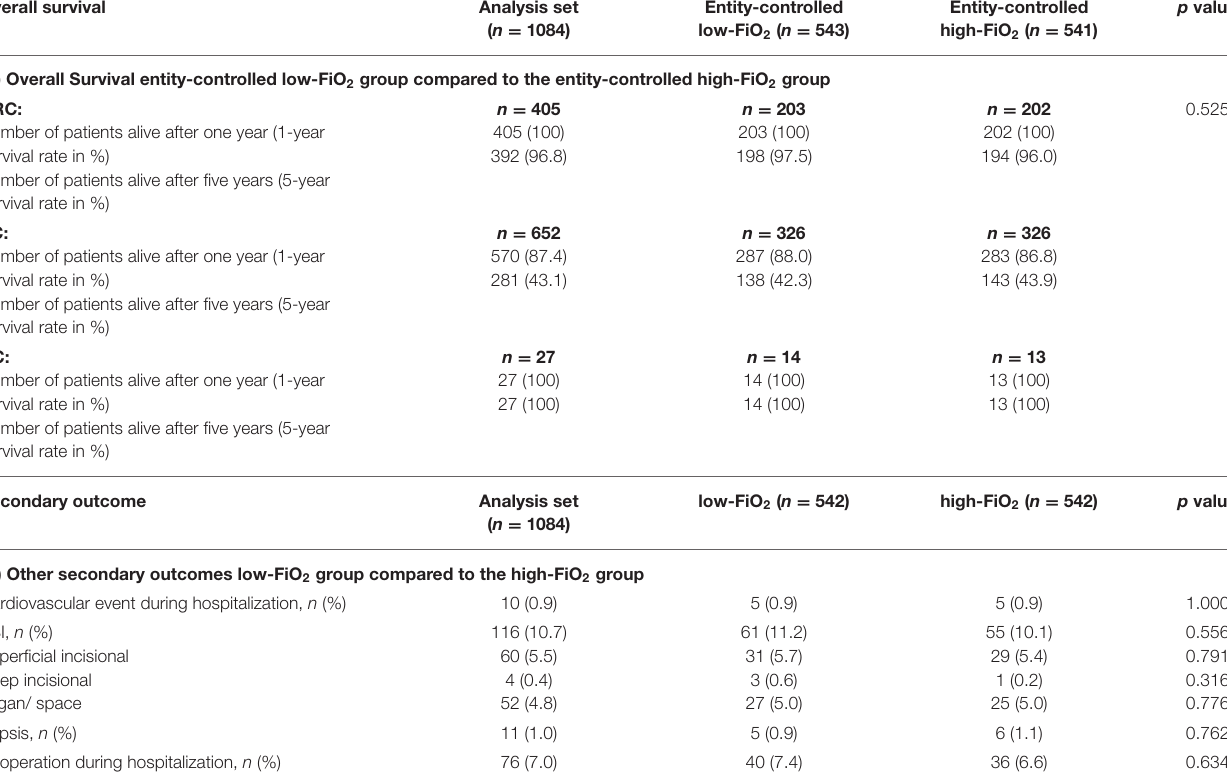
TABLE 4 | Secondary outcome analysis. Overall